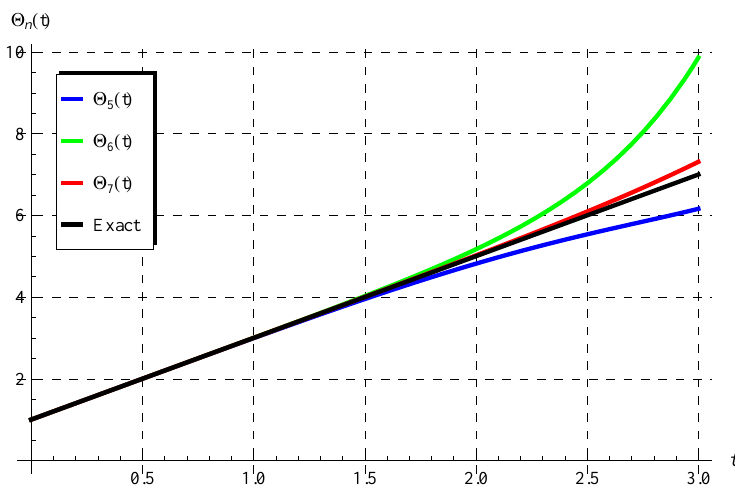
Figure 1. Comparisons between the approximate solutions Θ r ( t ) , r = 5,6,7 in Equation (75) and the exact solution (72) at λ = 1, a = b = α = 1 ( c = −